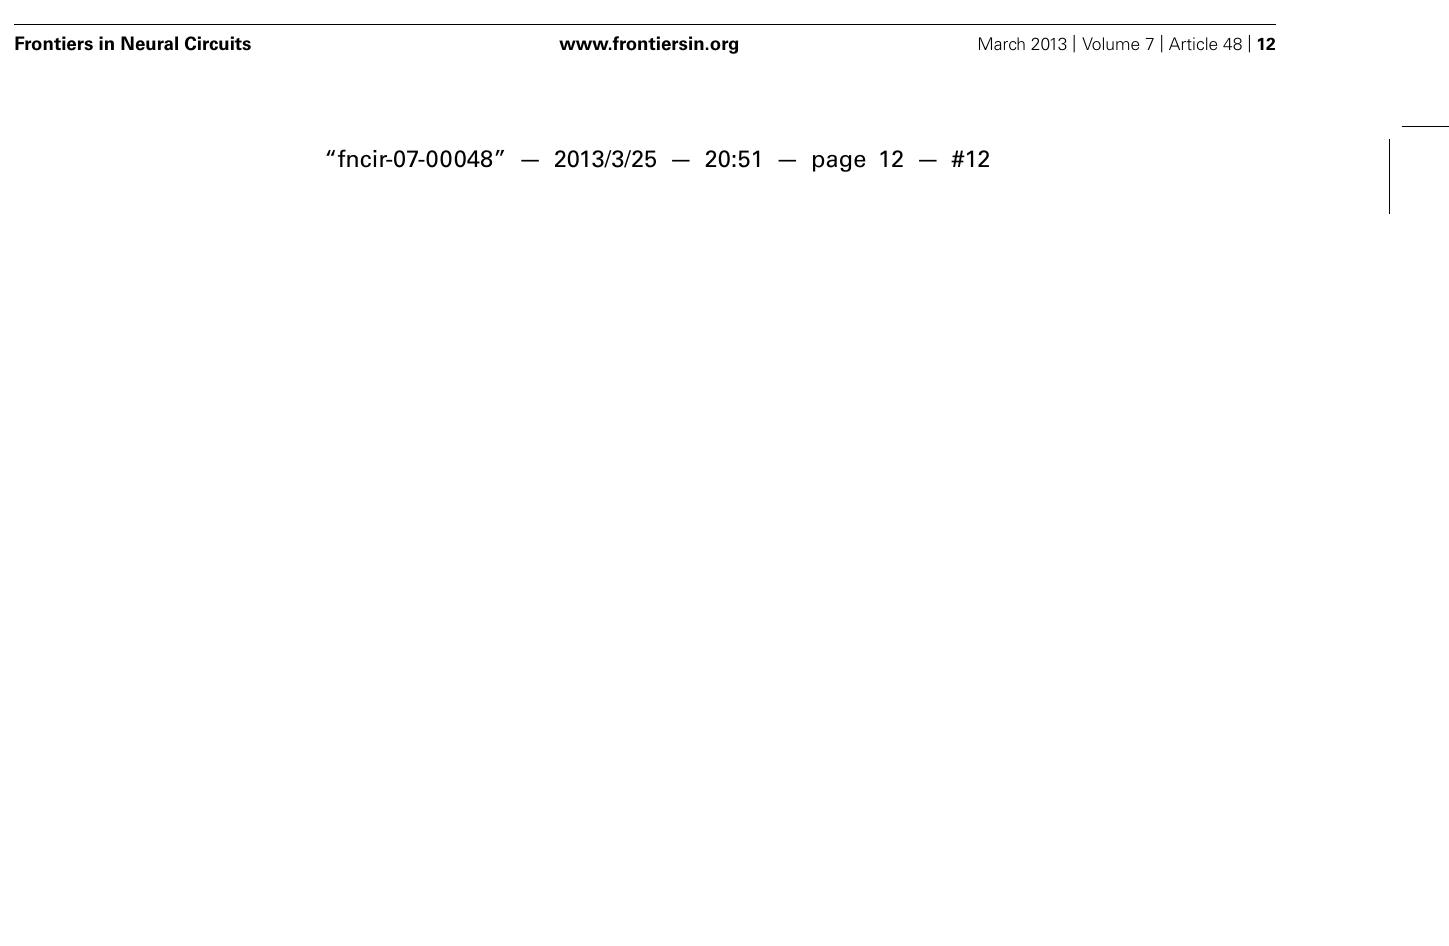
significant.The numbers correspond to the p -value for each combination. (A) MRP maps ( Figure 4 ) vs RF property maps ( Figure 9 ). (B) MRP maps vs spiking activity maps ( Figure 8 ). (C) Spiking activity maps vs RF property